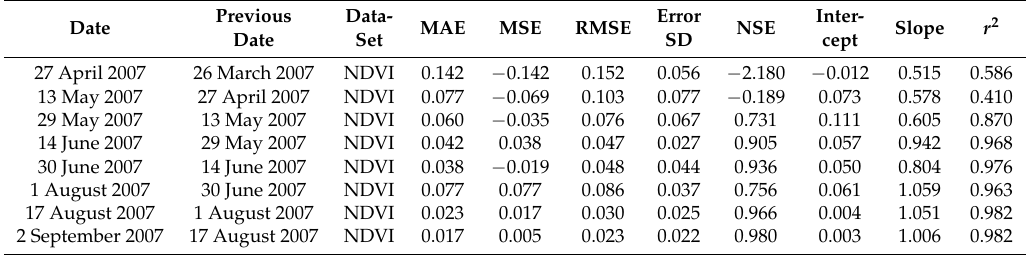
Table 4. Error and correlation statistics for full scene difference of Normalized Difference Vegetation Index (NDVI) values for observed and preceding Landsat scenes (i.e., the “null” model). Higher error indicates larger phenological changes between the given dates and serves as a baseline for determining model prediction accuracy in Tables 2 and 3.